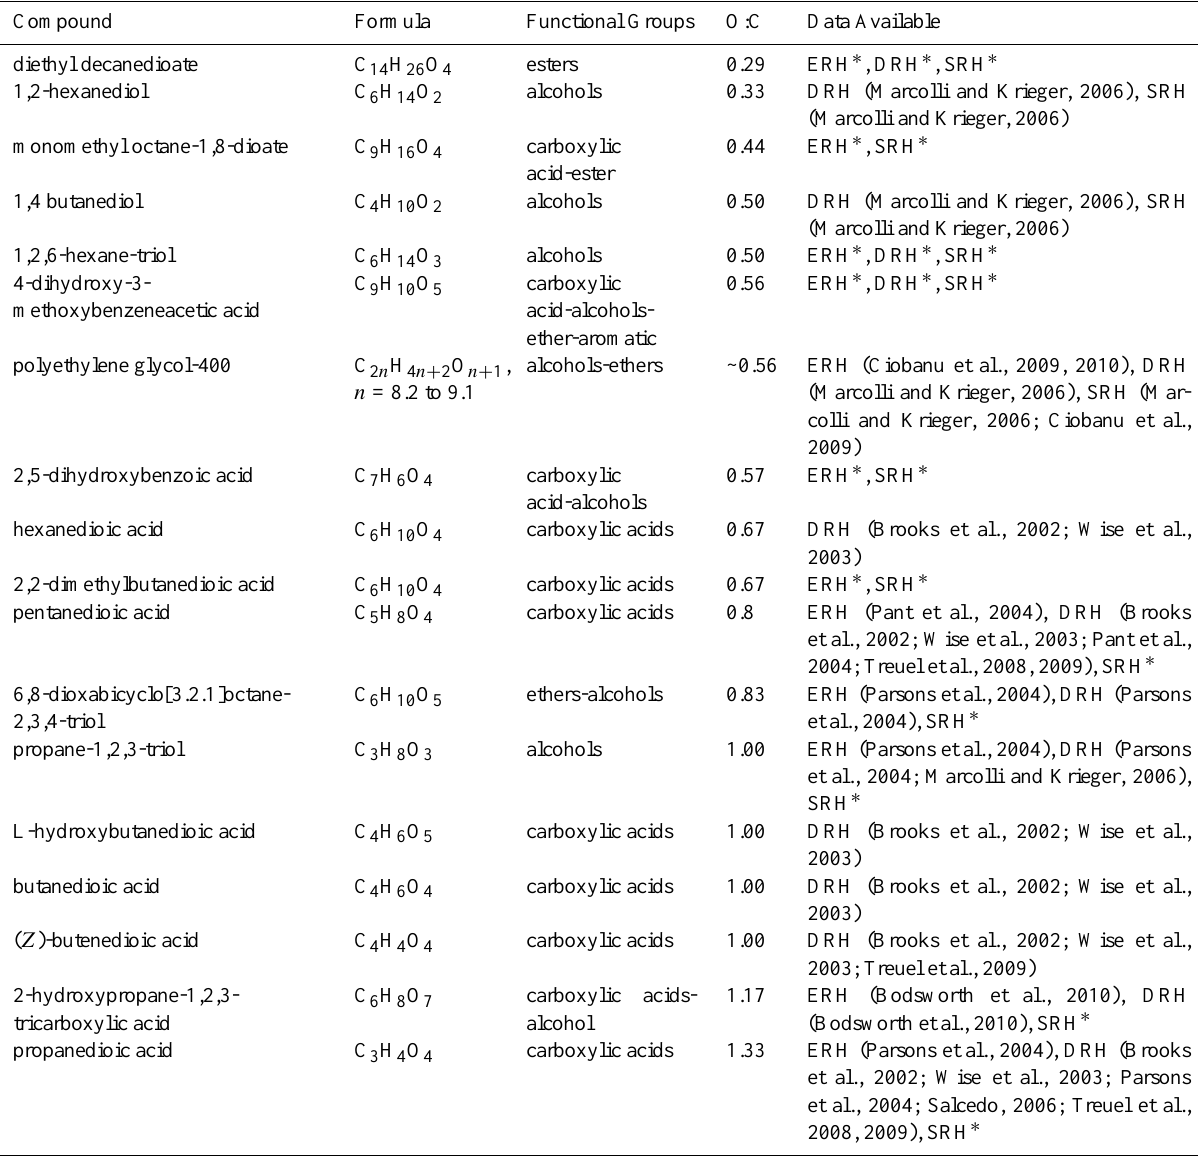
Table 1. List of the data sets used for the parameterisations of SRH, ERH, and DRH in three-component systems (i.e. one organic plus ammonium sulfate and water). Phase transitions were measured for temperatures ranging from 290 to 298K. Over this temperature range ERH and DRH does not strongly depend on temperature (Colberg et al., 2003; Bodsworth et al., 2010). Initial work with trihydroxyhexane and ammonium sulfate mixtures also suggest that SRH does not strongly depend on temperature over this narrow temperature range. The DRH values reported here corresponds to the total DRH, which indicates where ammonium sulfate completely dissolves. For DRH and SRH we only included results from either bulk measurements or optical microscopy measurements because other techniques typically used for exploring the hygroscopic properties of aerosol particles can miss total deliquescence. For ERH we focused exclusively on optical microscopy measurements to be consistent with the new results reported in the current manuscript. Optical microscopy has been shown to be in good agreement in most cases with other techniques used to measure ERH properties of particles (Parsons et al., 2004). We excluded ERH results if the ERH data increased with an increase in the org:sulf ratio. In this case, efflorescence most likely was due to crystallization of the organic material (a process that likely does not occur under most atmospheric conditions) (Marcolli et al., 2004). The complete data set is plotted in Fig. S1 as colour maps to illustrate that the data covers a wide range of org:sulf and O:C values without any large gaps in this phase space. Functional